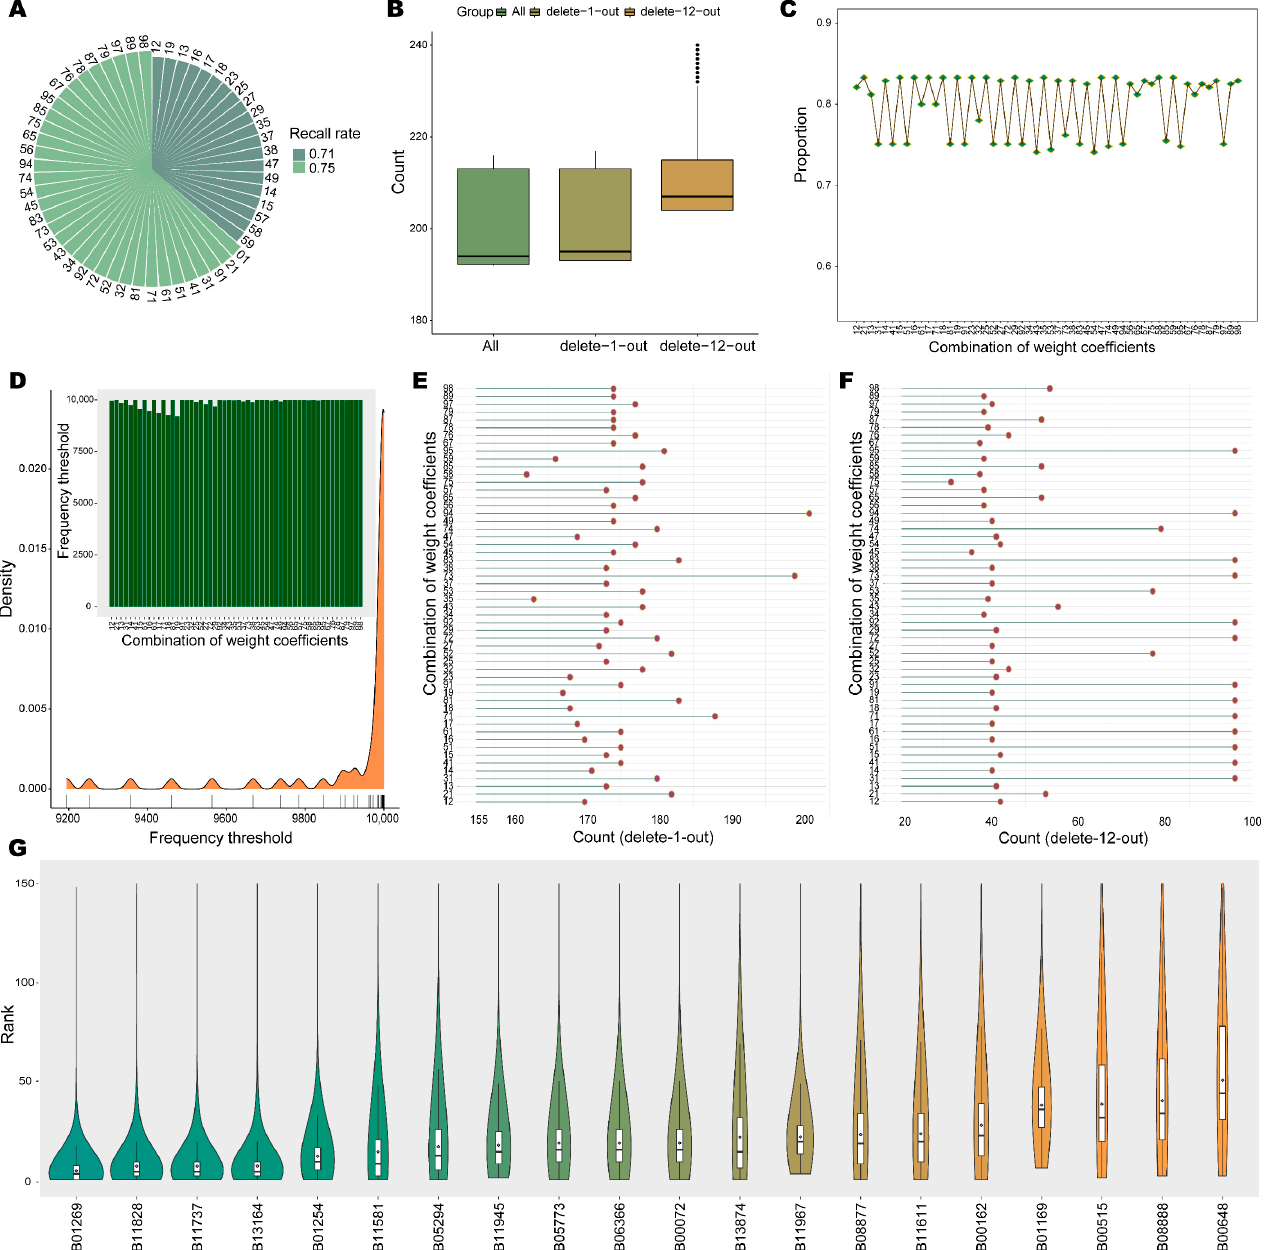
Figure 3. Stable drug candidates in weighted pattern. ( A ) The recall of the leave-one-out cross validation for each weighting pattern. ( B ) Distribution of the number of the top 5% of drugs. ( C ) The proportion of 160 intersecting drugs to the drug candidates identified by each weighted pattern. ( D ) Density curve of frequency thresholds under different weights by the delete-12-out strategy. Where the frequency threshold histogram corresponding to each weight is inserted. ( E , F ) The number of candidate drugs detected under different weights by the delete-n-out strategy. ( G ) Ranking distribution of stable drug candidates in all weighted patterns. Where the average rank is identified by a purple diamond.